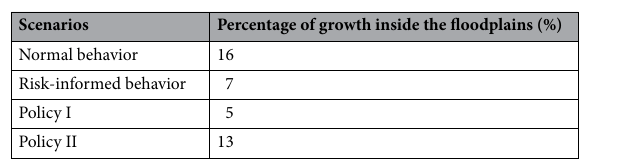
Table 3. Percentage of future residential buildings that are inside the 500-year floodplain.